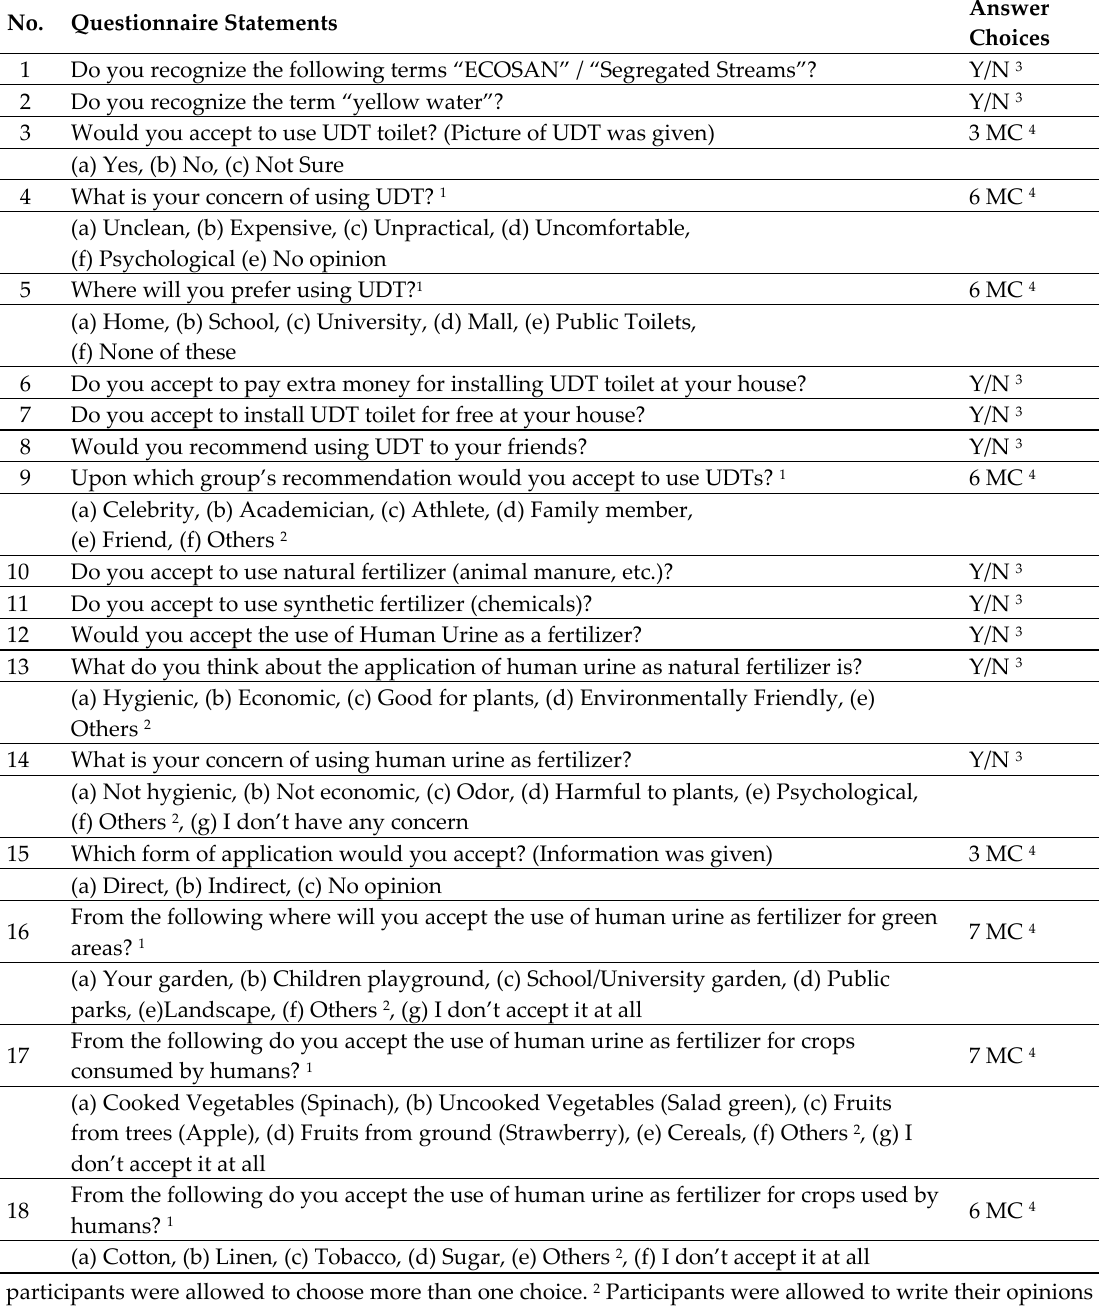
Table 1. Questionnaire statements and number of answer